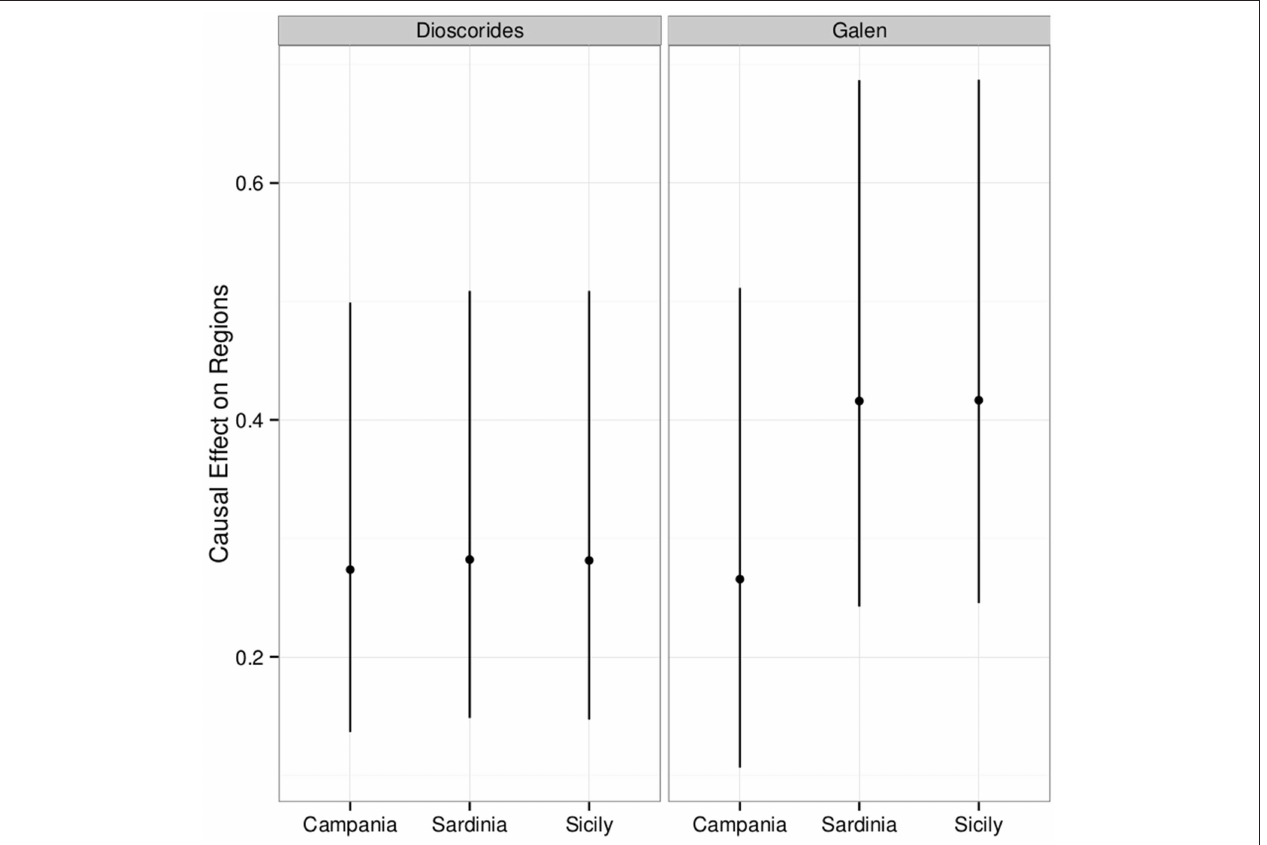
FIGURE 6 | Posterior distribution of the causal effect of Dioscorides and Galen on the contemporary plant use traits of the 87 taxa conditioned by the region of Campania, Sardinia, and Sicily. The plot shows the mean effect (point) along with the 95% credible